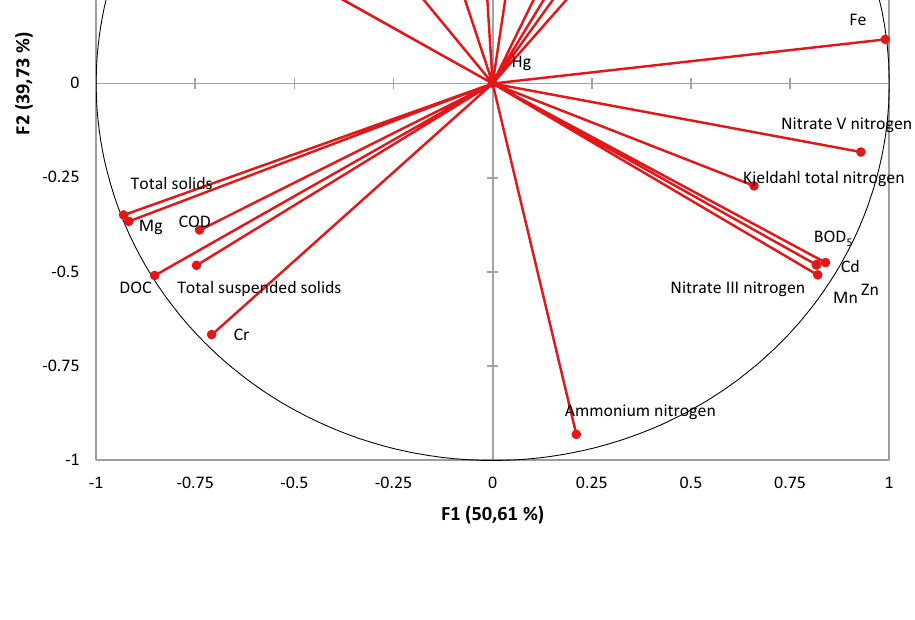
Fig. 10 Principal component analysis (biplot)—projection of variables set and objects cluster‑ ing in 2D factor loading space